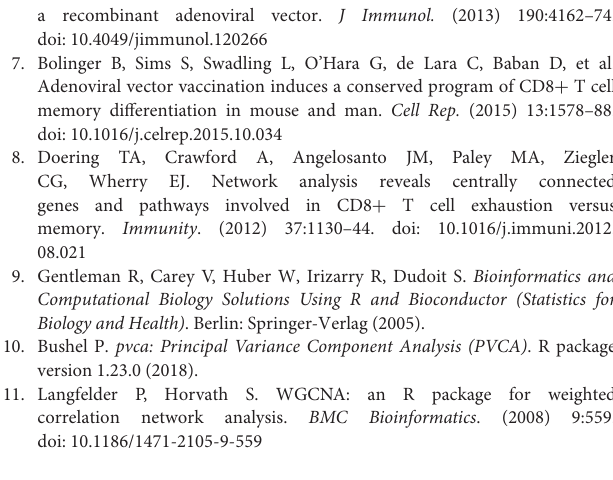
Figure S7 | Assessment of batch effect contribution prior and after ComBat processing. An analysis by pvca R package was performed to estimate the variability of experimental effects. Table S1 | (A,B) GO term enrichment analysis of WGCNA modules. GO categories enrichment analysis in modules detected including all Inflating samples ( A , β = 9) and excluding possible outliers ( B , β = 20). Table S2 | (A–C) TOM matrices of blue and turquoise modules. Table matrices with topological overlay measures (TOM) of blue modules detected including all samples (A) or excluding possible outliers (B) ; TOM matrix of turquoise module including all inflating samples (C) . Table S3 | GSEA report of Reactome gene sets enriched in Inflation. GSEA report of Reactome curated pathways found enriched (FDR < 0.25) in Inflating samples (M38, days 50) vs. Exhausting samples (Cl13, days 30). Table S4 | GSEA report of Reactome gene sets enriched in Exhaustion. GSEA report of Reactome curated pathways found enriched (FDR < 0.25) in Exhausting samples (Cl13, days 30) vs. Inflating samples (M38, days 50). Table S5 | (A,B) GSEA reports of MsigDB Immunological Signatures gene sets in Inflation and Exhaustion. GSEA reports of immunological signatures found enriched (FDR < 0.25) in Inflating samples (A) (M38, days 50) vs. Exhausting samples (B) (Cl13, days 30). Supplementary Materials and Methods | Relevant R and Bioconductor packages and versions